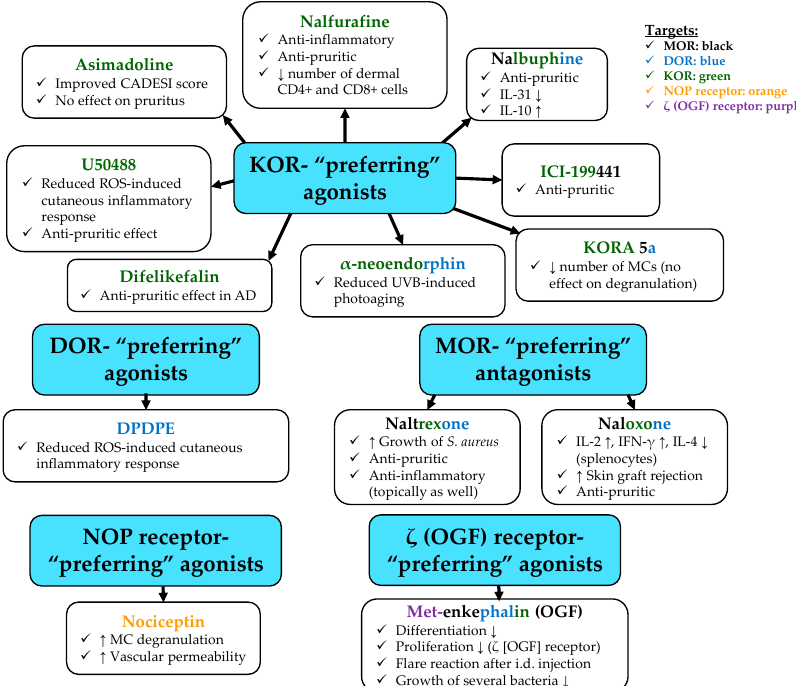
Figure 4. Overview of the “AD-relevant” effects of selected modulators of the key opioid receptors. Note that most of the above compounds are not selective (for details, see Figure 2) but can rather concentration dependently activate/antagonize multiple opioid receptors. The color code indicates the relevant targets of each molecule. When one molecule can activate or antagonize more than one receptor, the order of the colors from the left to the right represents the order of the affinity toward each receptor. For example, the order of colors in the case of “ Naltrexone ” ( black-green-blue ) indi-